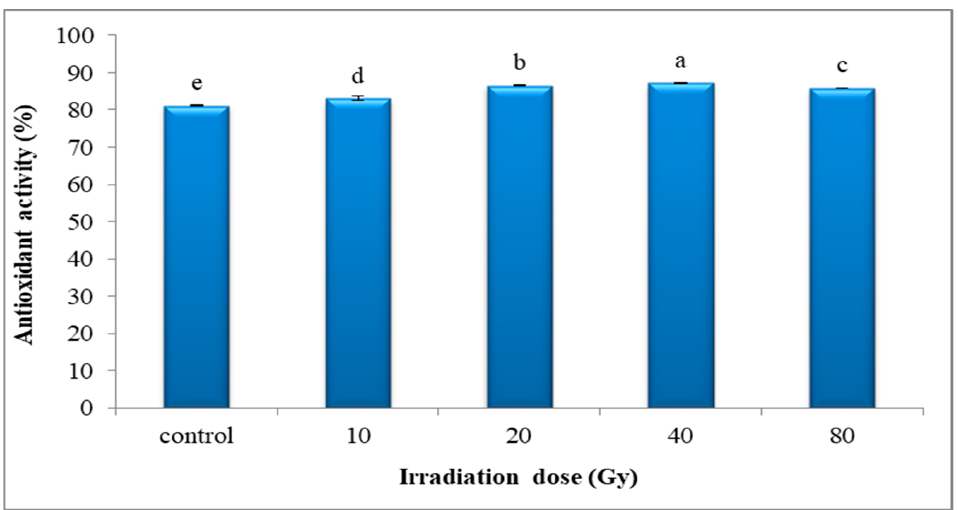
Figure 7. Antioxidant activity (%) of red radish roots affected by gamma rays at different dose levels. Findings are means ± standard deviations (n = 3). Different letters point to significant variations at p ≤ 0.05; bars indicate standard deviations.